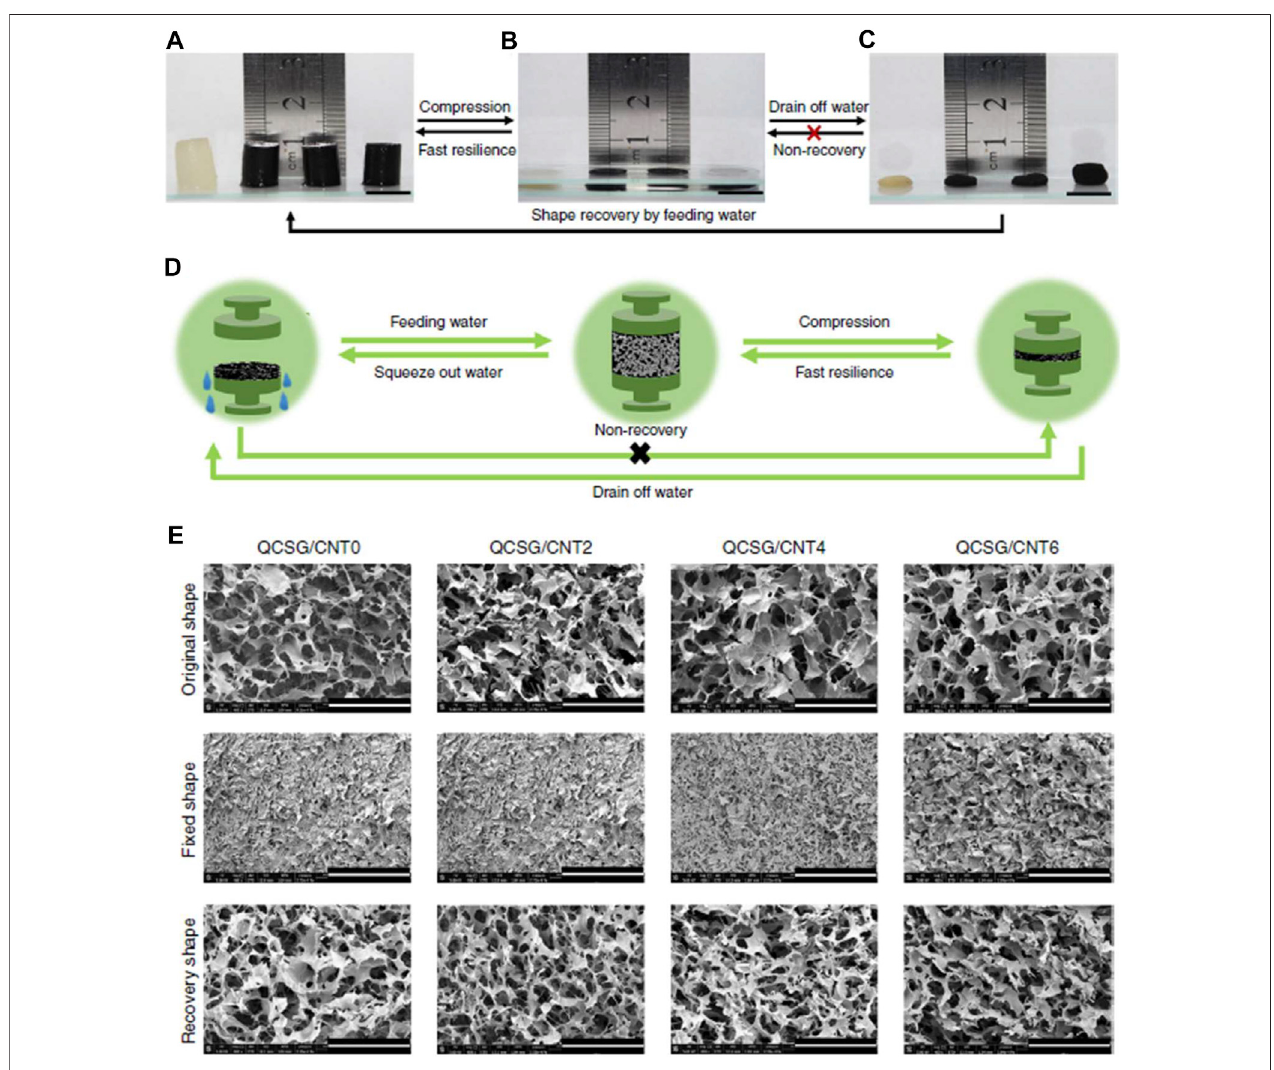
FIGURE 1 | Shape memory properties of the cryogels. (A – C) Fast resilience and macroscopical shape memory property of the cryogels. Scale bar: 1 cm. (D) Schematic representation of the shape memory mechanism of the cryogel. (E) Microtopography of the cryogels in original state, shape- fi xed state and shape recovery state after fi xing. Scale bar: 400 μ m. Reproduced from (Zhao et al., 2018) with permission from Copyright 2018 Springer.